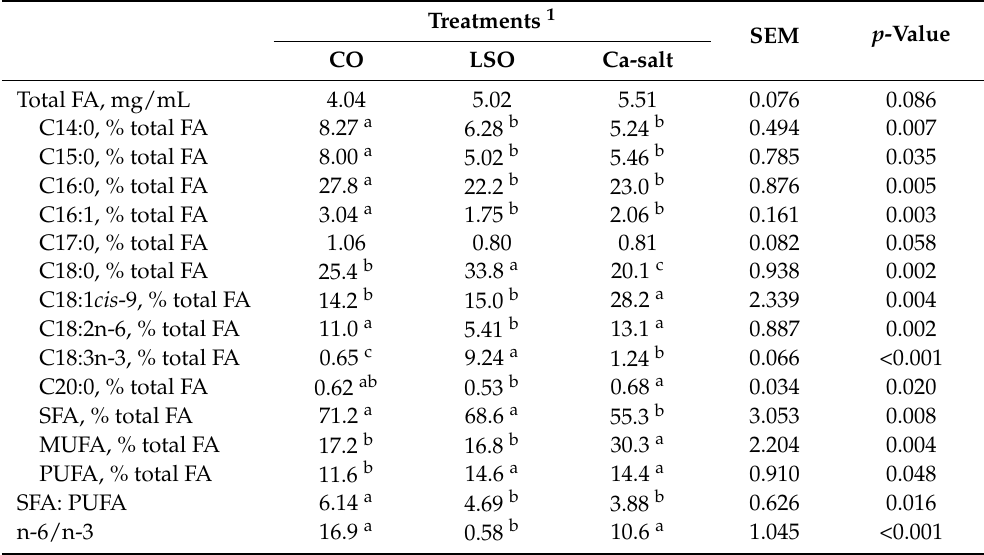
Figure 3. Fold changes in rumen microbes compared to that during rumen incubation with oil sources containing essential fatty acid for 24 h of incubation. Diet with corn oil, C18:2n-6 (●); diet with linseed oil, C18:3n-3 ( ■ ); and diet with Ca-salt, protected C18:2n-6 ( ▲ ). The respective significance levels of dietary treatment, incubation time, dietary treatment × incubation time, and SEM for Methanogenic archaea, rumen ciliates, F. succionogens , R. albus , S. bovis , and R. flavefaciens are p < 0.001, p < 0.001, p < 0.001, and SEM = 0.157; p < 0.001, p = 0.803, p = 0.838, and SEM = 0.283; p < 0.001, p < 0.001, p = 0.014, and SEM = 0.138; p < 0.001, p < 0.001, p < 0.001, and SEM = 0.336; p < 0.001, p < 0.001, p < 0.001, and SEM = 0.263; and p < 0.001, p < 0.001, p < 0.001, and SEM = 0.198. Different symbol at the same time differ (*, p < 0.05; **, p < 0.01). Table 6. Supplementation effects of oil sources containing essential fatty acid on fatty acid profiles of rumen buffer after 24 h of